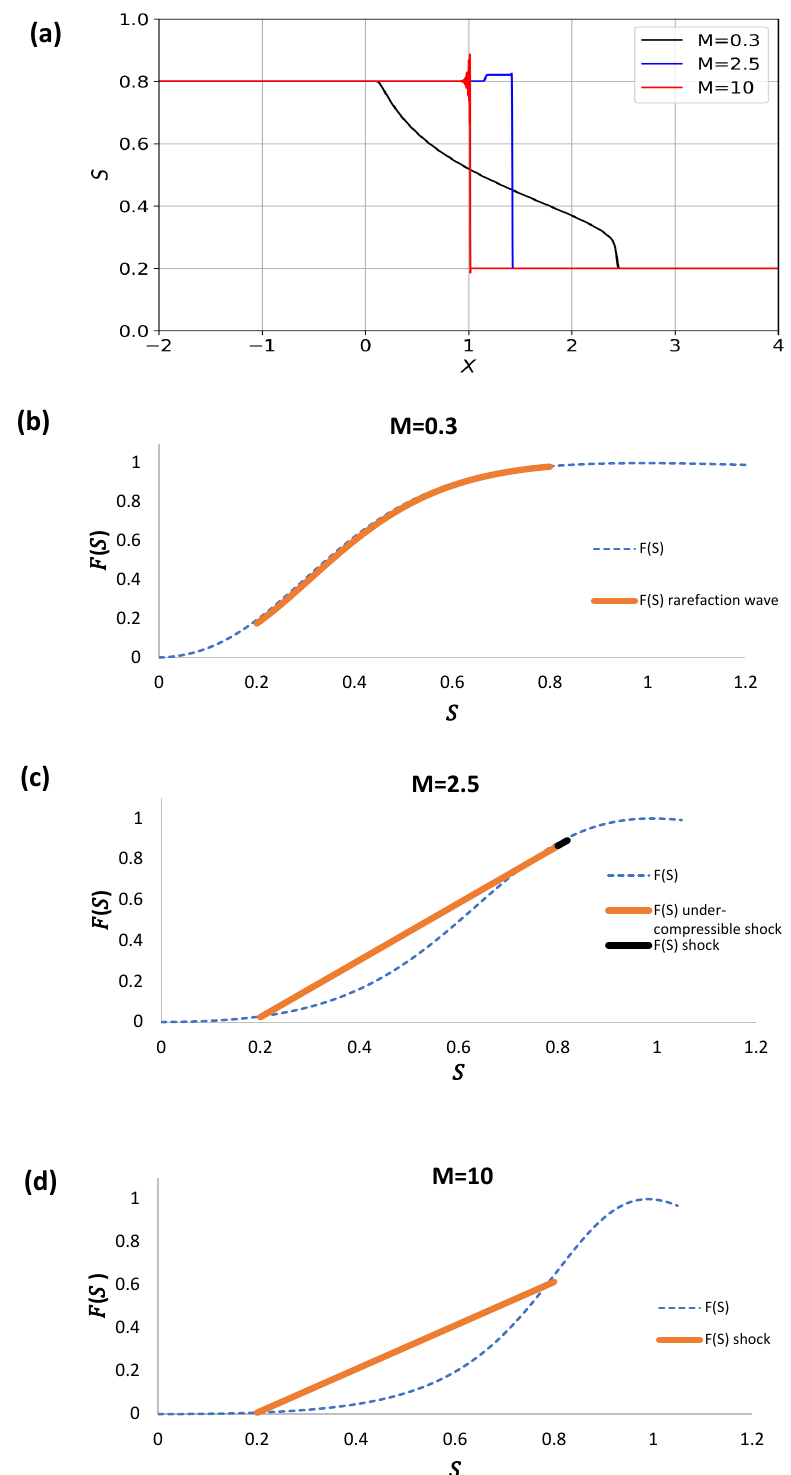
Figure 13. ( a ) The rarefaction wave evolves into a shock trailing the under-compressible shock for M = 2.5 and alternatively evolving into an under-compressive shock for M = 10. ( b – d ) The shock behaviour changes from a rarefaction wave at low mobility ratios into a small shock trailing an under-compressive shock at high mobility